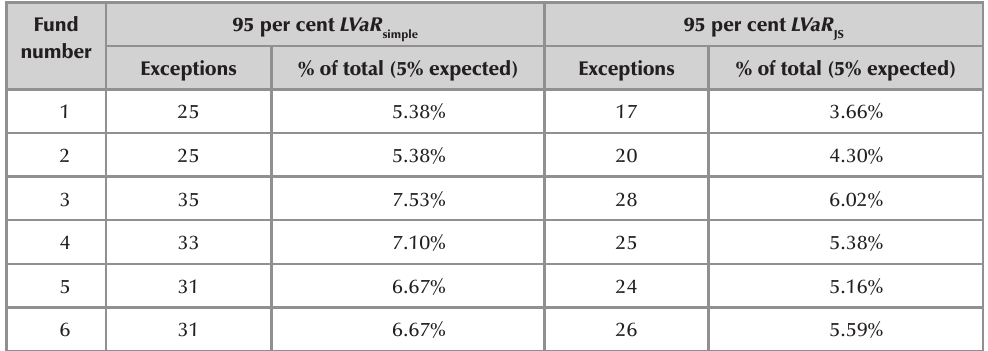
Comparison of 95% LVaR forecast exceptions measured over 466 days for all